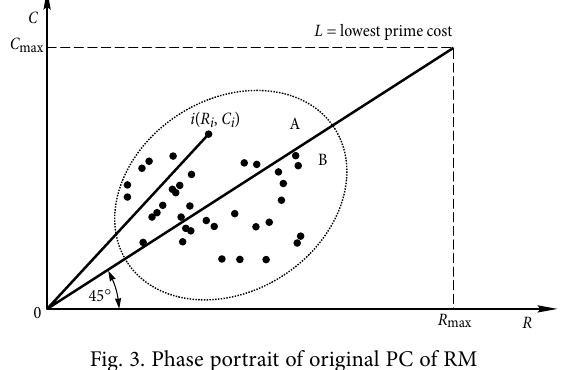
Fig. 3. Phase portrait of original PC of